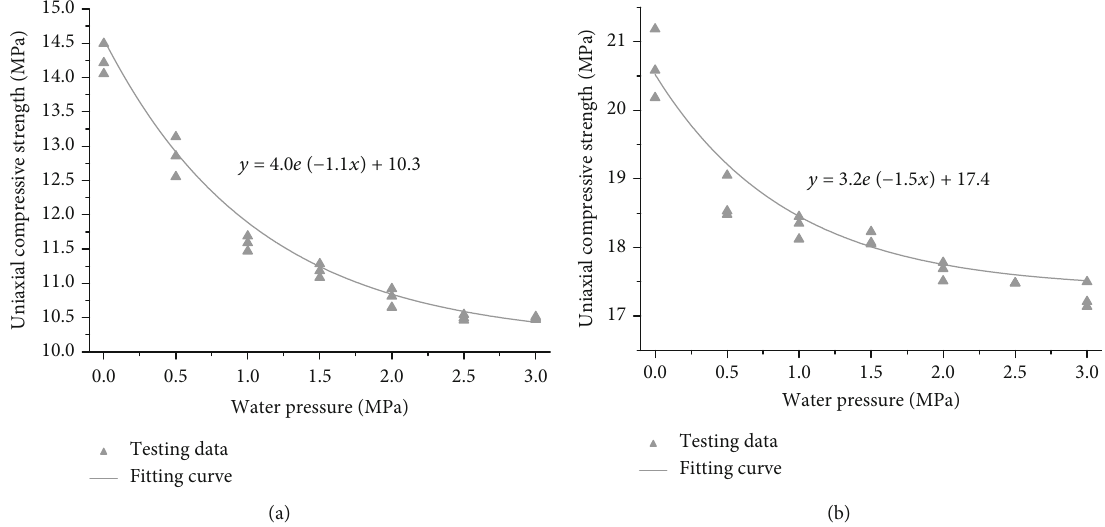
Figure 2: The uniaxial compressive strength changes with water injection ((a) coal samples from the Pingdingshan No. 10 coal mine; (b) coal samples from the Gushuyuan coal mine).